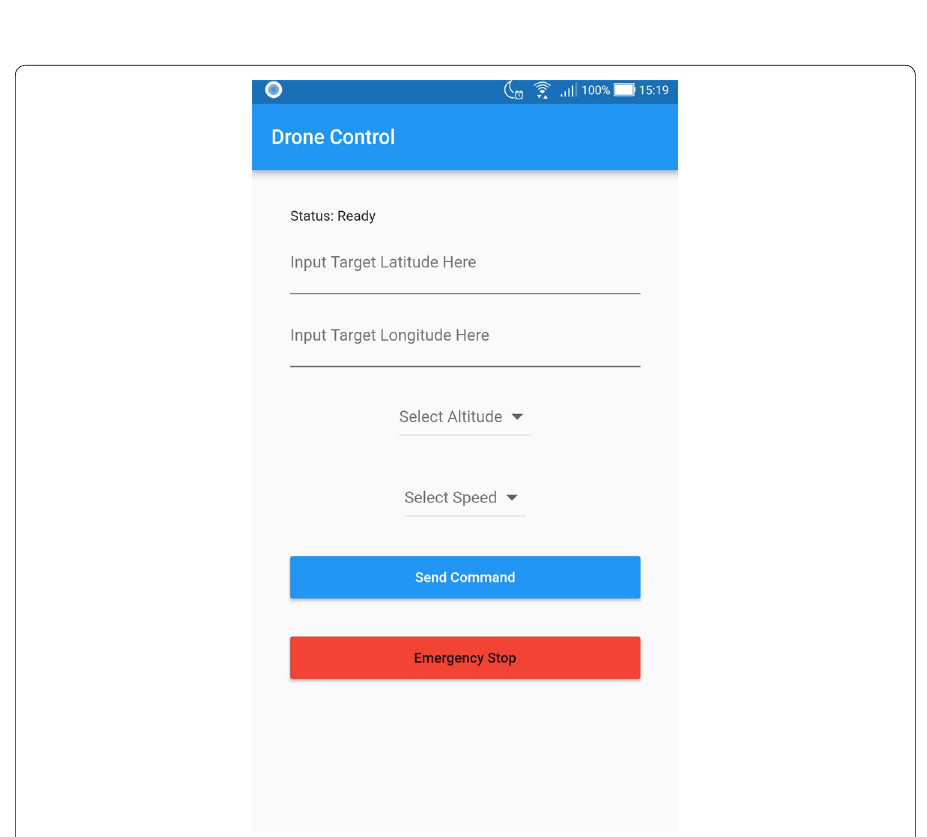
Fig. 12 The interface of the mobile